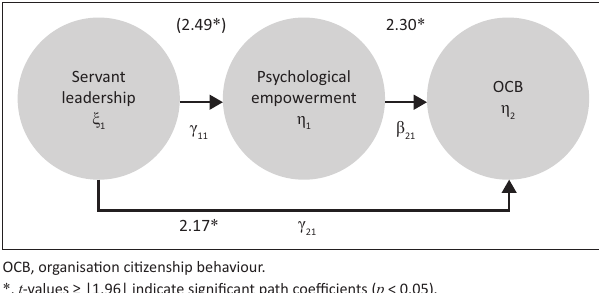
FIGURE 1: The conceptual structural